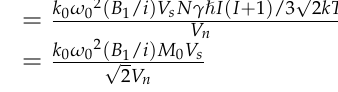
Figure 4. An NSS − NMR experimental system based on a mixed magnet, an orthogonal dual-coil probe and data acquisition subsystem.